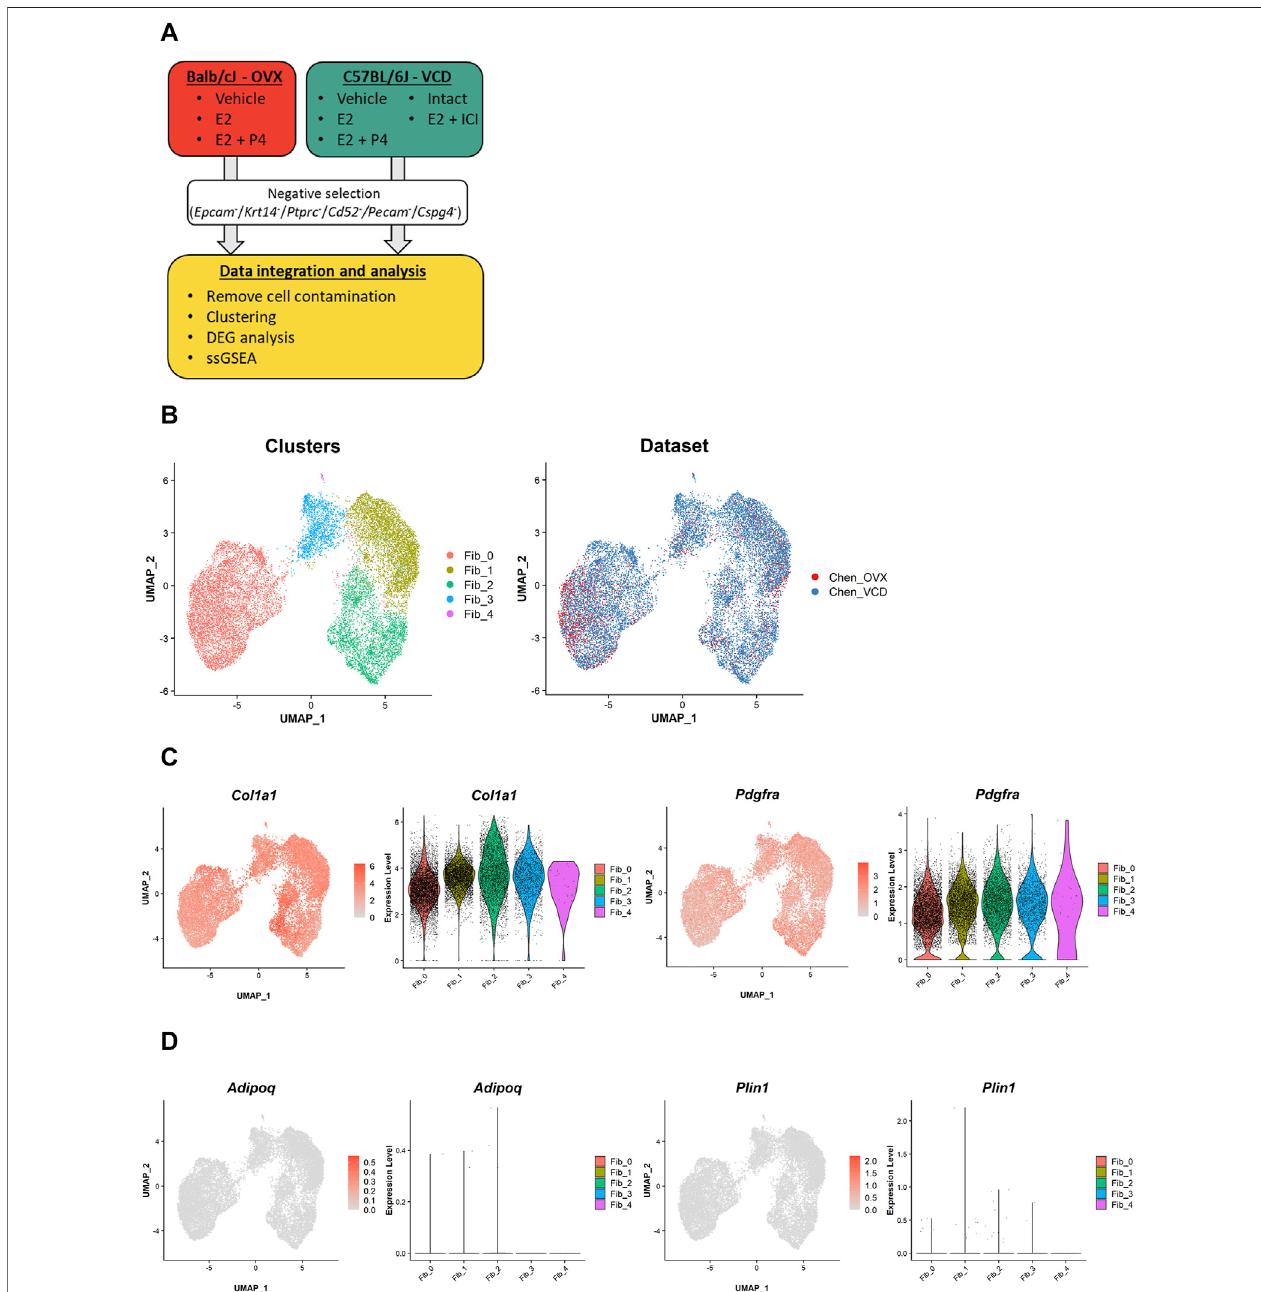
FIGURE 1 | Our scRNA-seq datasets identify two major clusters of mammary gland fi broblasts commonly existing in the two different mouse models. (A) The schematic diagram of data processing and analyses for our own scRNA-seq datasets from the OVX and VCD models. The single-cell data were corrected from the mammary glands of the two models. Then, mammary gland fi broblasts were sorted by negative selection (i.e., sorting for cells without read counts for Epcam , Krt14 , Ptprc , Cd52 , Pecam1 , and Cspg4 ). After the additional removal of a small fraction of cell contamination from other lineages of cells, the fi broblast dataset was integrated and evaluated in the downstream analyses (i.e., clustering, DEG analysis, and ssGSEA scoring). (B) The UMAP plot of the integrated dataset. Each cell is represented by a dot ( n = 16,197) and is colored according to the cluster identi fi ed by the unbiased clustering (left) and the originated datasets (right). (C) The expression of the fi broblast markers ( Col1a1 and Pdgfra ) and (D) the mature adipocyte markers ( Adipoq and Plin1 ). Each feature plot on the left panel shows the distribution of the marker-expressing cells with color indicating the expression level. Each violin plot on the right panel shows the expression level of each gene in each cluster.